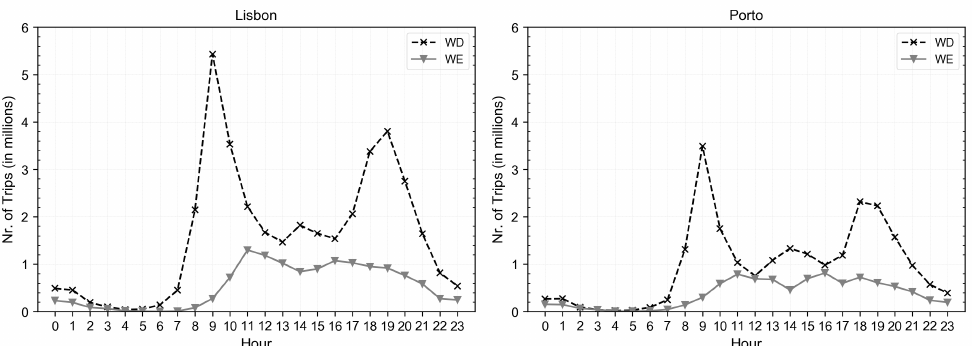
Figure 10. Number of trips along the day for weekdays (WD) and weekends (WE) in 2017 for Lisbon ( left ) and Porto ( right ) metropolitan